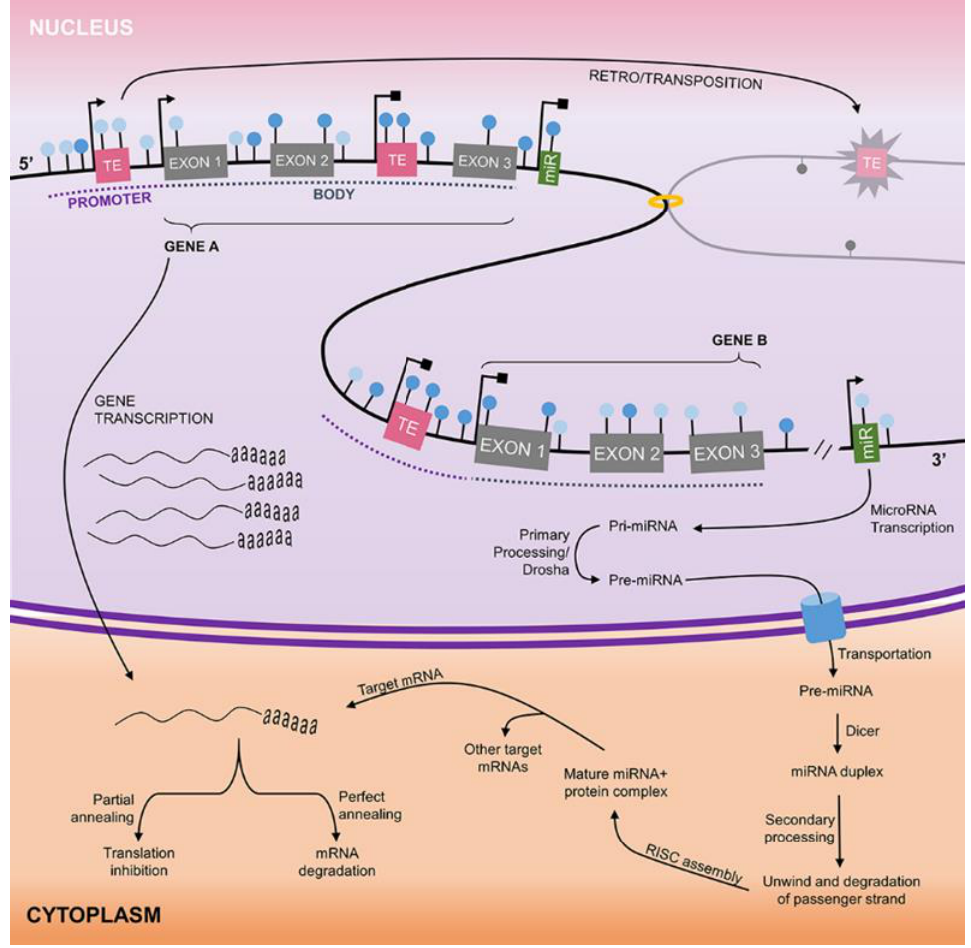
Figure 1. Overview of gene regulation by DNA methylation and miRNA activity. Genomic DNA, found in the nucleus of eukaryotic cells, contains millions of CpG sites (lollipops) that can be either methylated (dark blue) or demethylated (light blue). These CpG sites are located in gene promoters and bodies, miRNAs, and intergenic regions, as well as in the vicinity of transposable elements (TE). When a promoter region is demethylated (Gene A), gene transcription may take place, leading to mRNA synthesis. However, when the promoter is hypermethylated (Gene B), transcription is inhibited. TEs transcription goes through the same regulatory mechanism. The transcription of some of these elements leads to the production of the transposition machinery, which enables their retrotransposition to a new genomic region, in a “copy–paste” fashion. DNA methylation similarly regulates the expression of miRNAs. Once transcribed, the primary miRNA (Pri-miRNA) is processed still in the nucleus by the RNAse Drosha, forming the precursor miRNA (Pre-miRNA). The Pre-miRNA is exported to the cytoplasm, where it is further processed by the RNAse Dicer, forming the miRNA duplex. After the miRNA duplex unwinds and the degradation of the passenger strand takes place, the lead strand (mature miRNA) assembles to the RNA-induced silencing complex (RISC) and, by nucleotide complementarity, identifies their target mRNAs. A single miRNA may have several mRNA targets and will lead to their degradation (perfect annealing) or translation inhibition (partial annealing).